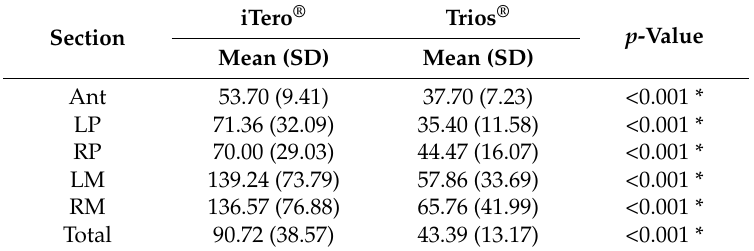
Table 6. Comparison of deviations of the scanned images among sections in iTero ® and Trios ® (unit: µ